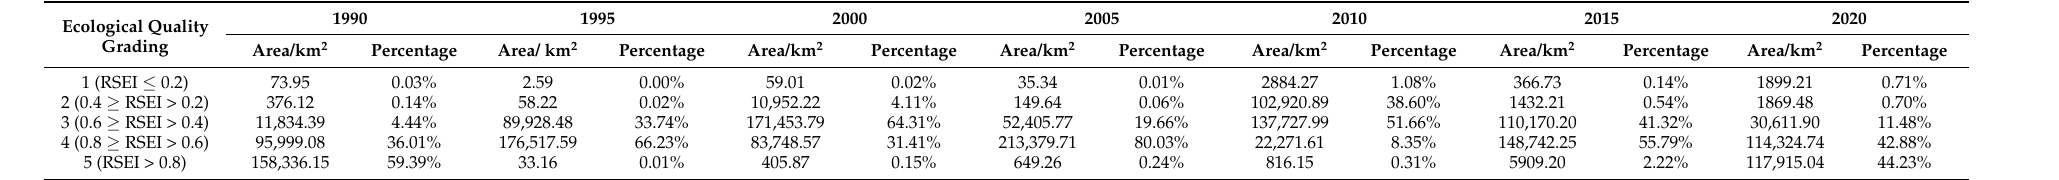
Table 2. Hierarchical Statistics of Ecological Quality in Yunnan Karst Rocky Desertification Areas (1990–2020).